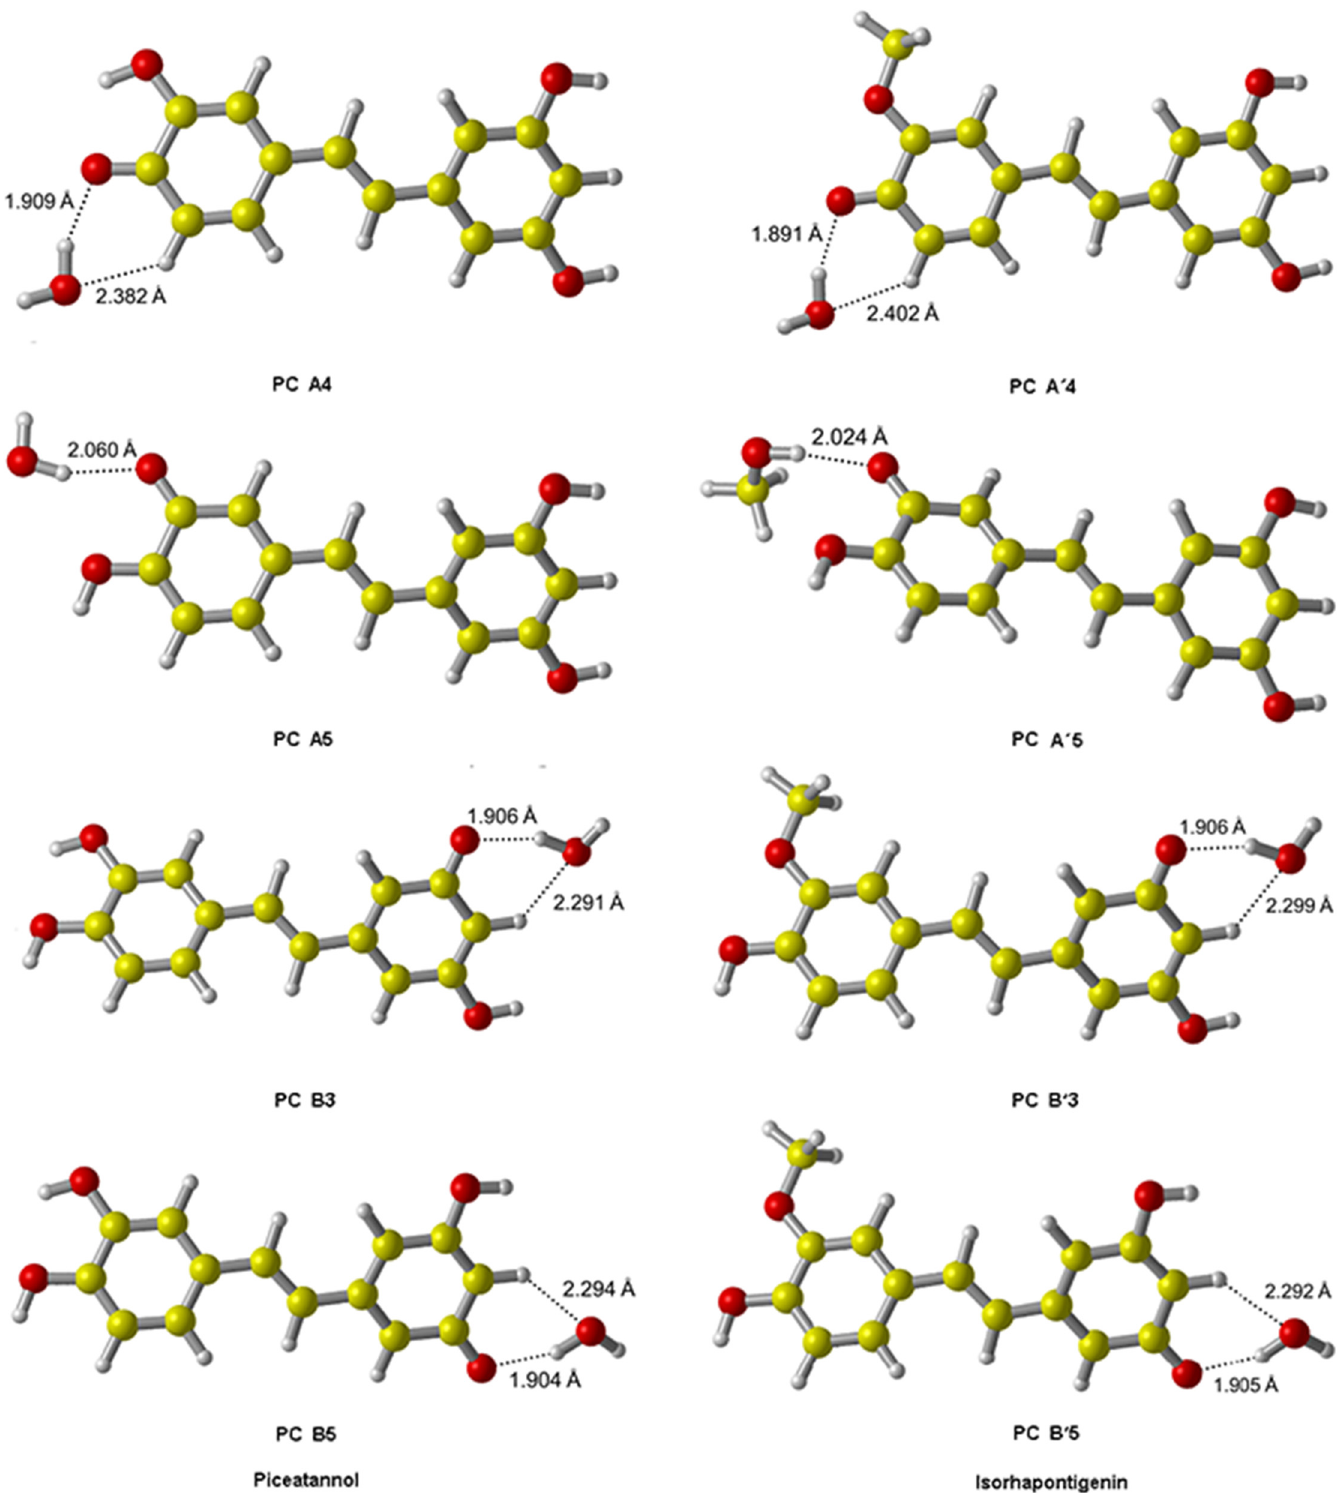
Fig 2. The optimized geometries of the product complexes of PIC and ISO from ABS reactions initiated by (cid:129) OH. In these structures, the water molecule forms a hydrogen bond with the PIC/ISO semiquinone radical.